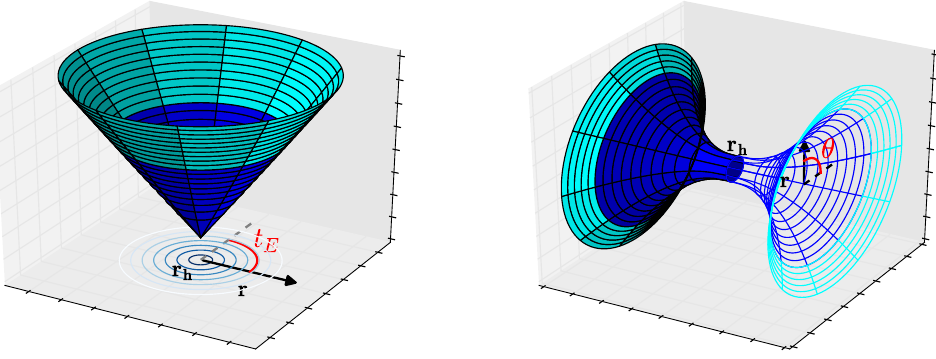
Figure 5 . Euclidean manifold for Schwarzschild(-AdS). Light/dark blue respectively refers to outside/inside the shell. Left: Euclidean time vs radius plane embedded in a higher dimension. The cusp can be smoothed out by a suitable choice of euclidean period. Right: angular vs radius plane with one angular coordinate suppressed. We can see the well-know Schwarzschild throat.